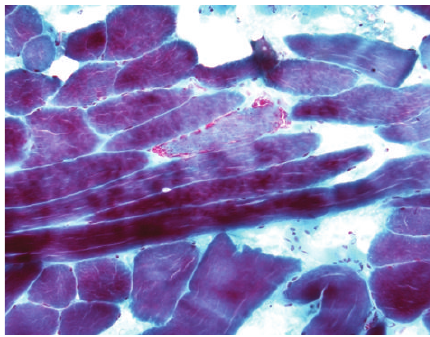
Figure 2: Muscle biopsy (modified Gomori trichrome) showing moderate numbers of fibrils with a red-ragged appearance with accumulation of red reaction product in the subsarcolemmal region and between myofibrils.